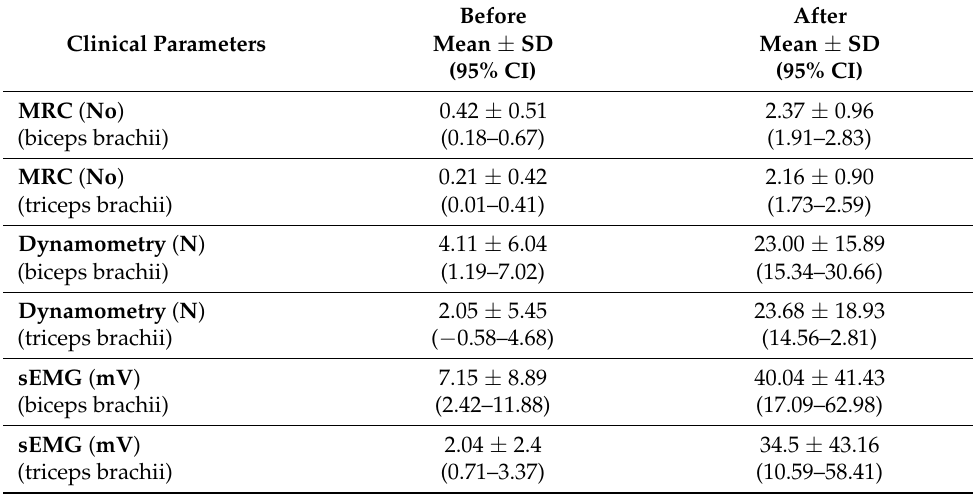
Table 1. Pre- and post-intervention values.